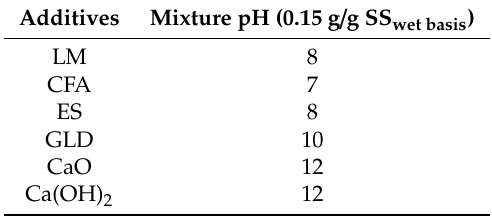
Table 5. Final pH of the SS after chemical treatment with additives.